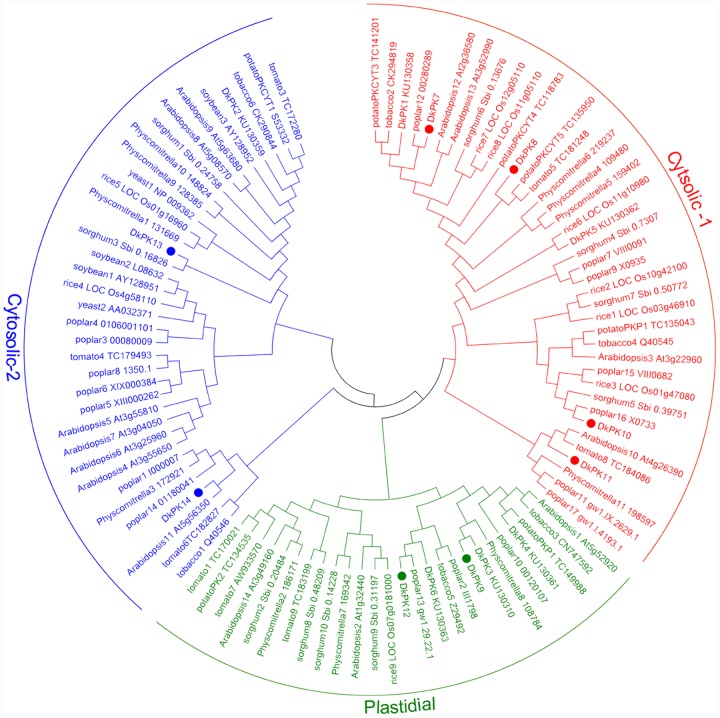
Phylogenetic analysis of deduced DkPK amino acid sequences. DkPK proteins from other species were obtained from NCBI and Oliver et al. (2008); the deduced amino acid sequences of DkPK1-6 were obtained from Guan et al. (2016). The persimmon PK7-14 proteins are marked with filled circles. The phylogenetic tree was constructed with MEGA6.